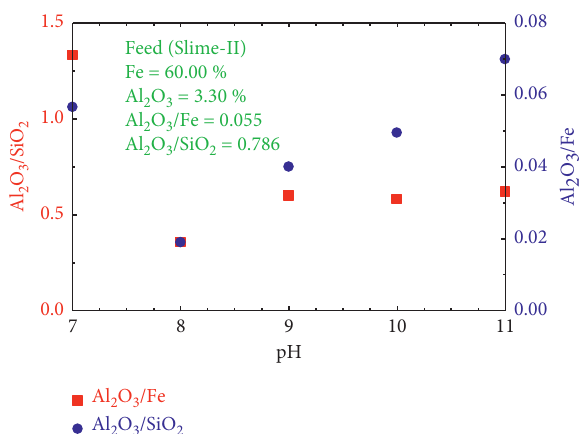
Figure 4: Plot of the pH effect on the Al ratios in the concentrate obtained from 10 wt. % slurry of slime at 5ppm AD 200.